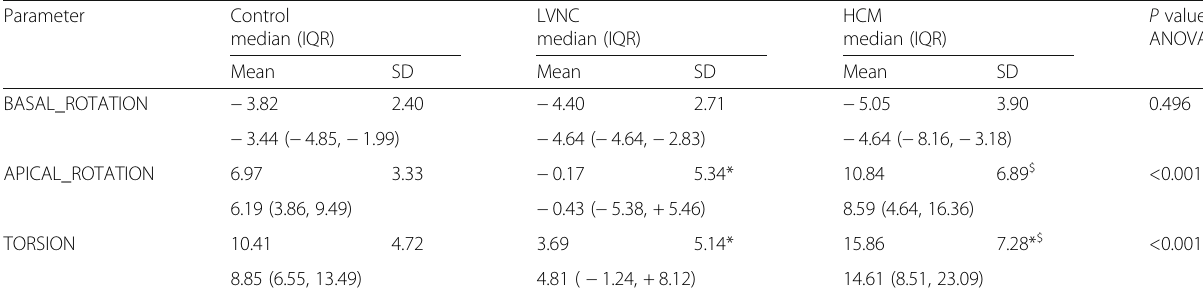
Table 4 Myocardial deformation parameters in LVNC, HCM, and controls